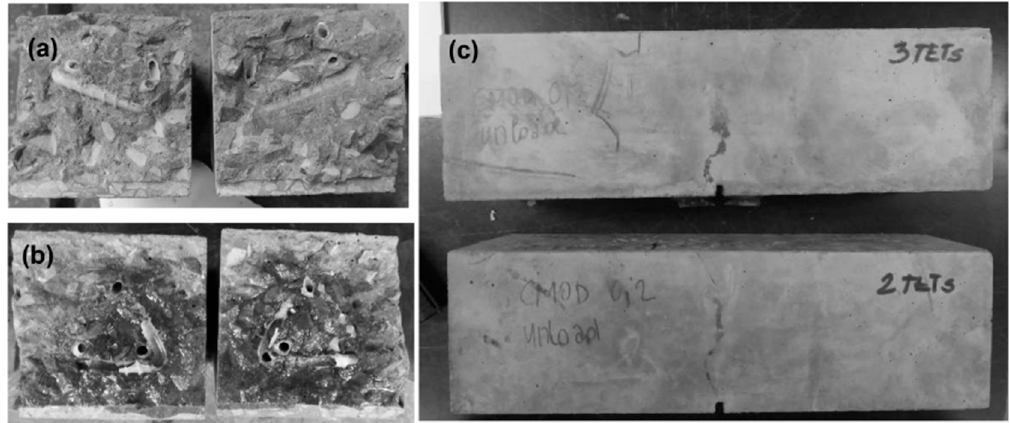
Figure 9. Group 1: ( a ) samples with empty TETs after breakage; ( b ) samples with 2 TETs filled with SS after breakage; ( c ) evidence of TET breakage and SS release after the pre-cracking phase.